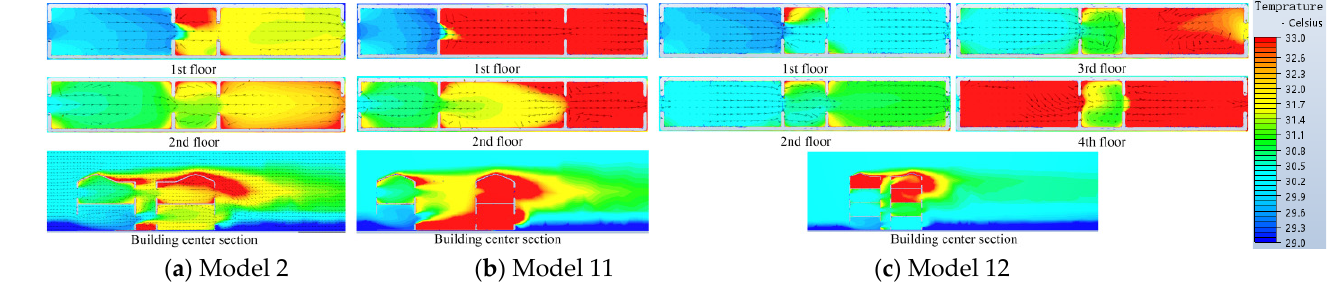
Figure 13. Simulated spatial distributions of T a in Models 2, 11, and 12 at 12:00 at 1.2 m height on each floor.